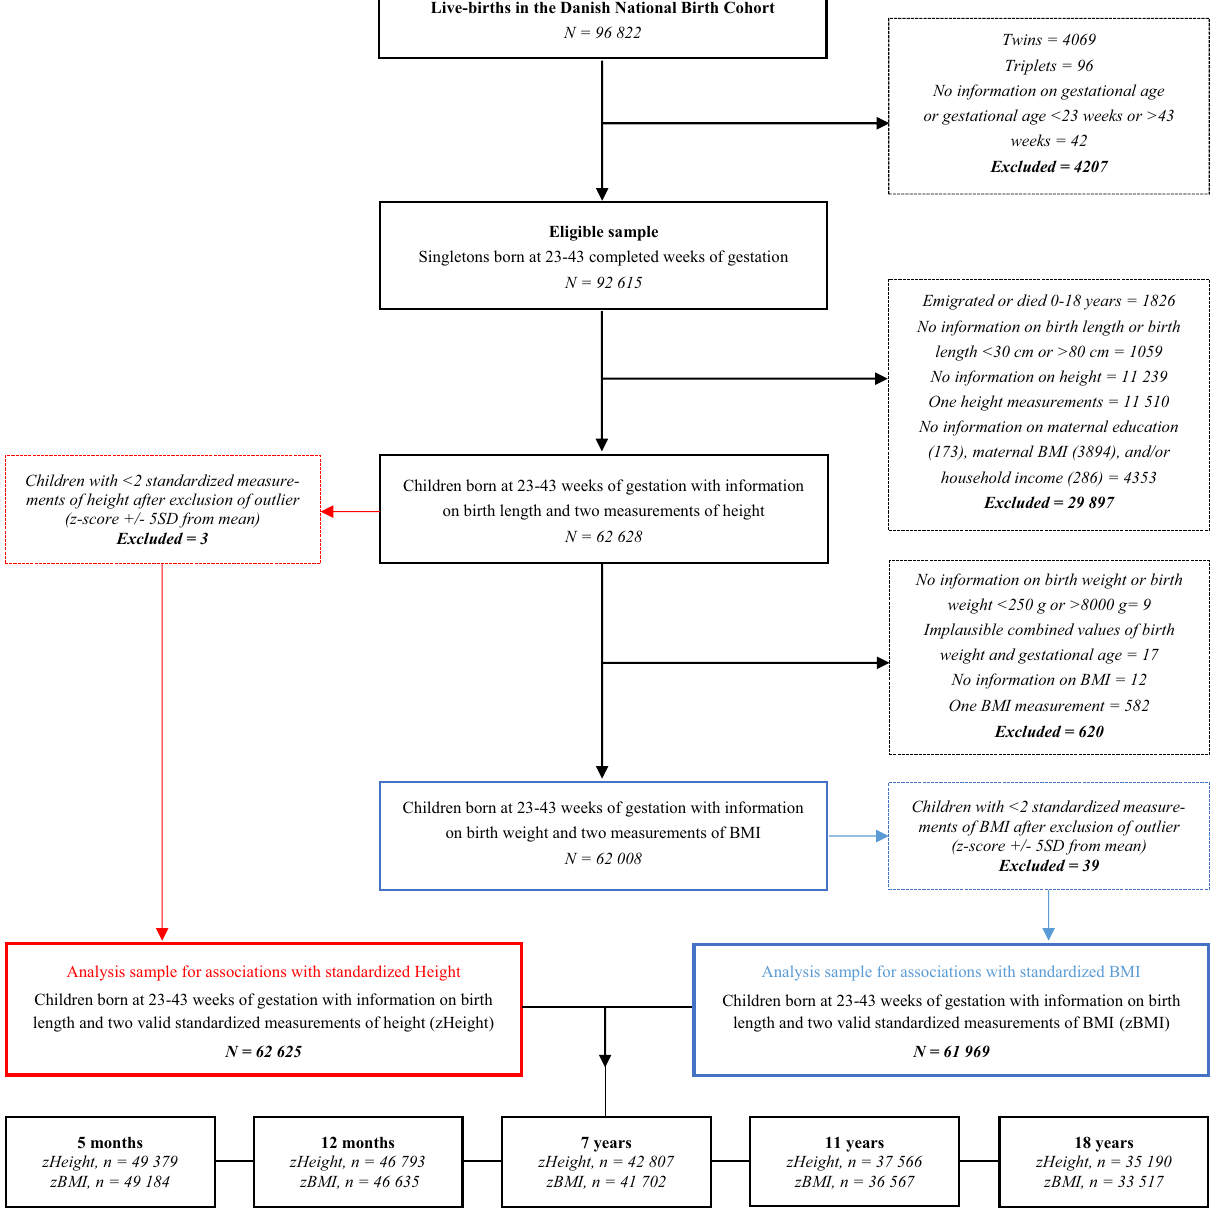
Figure 1. Flow chart of eligibility and inclusion in the study population in the